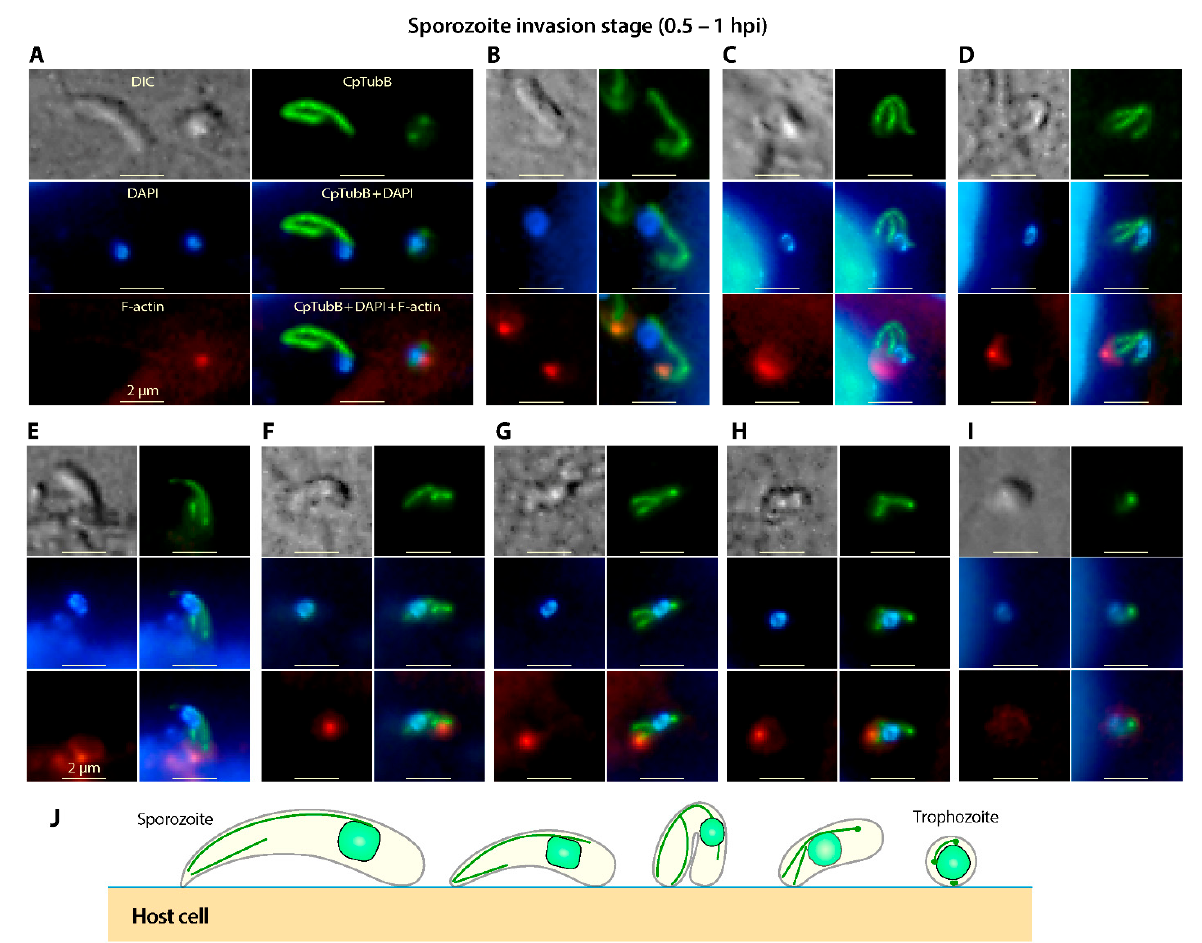
Figure 4. IFA detection of tubulin-based structures in Cryptosporidium parvum during the invasion of the host cell by sporozoites and its development into trophozoites by anti-CpTubB antibody (green). Nuclei were counterstained with 4 ′ ,6-diamidino-2-phenylindole (DAPI) (blue). Panels ( A – I ) represent various stages of transformation of banana-shaped sporozoites into small round trophozoites. Aggregated host cell F-actin at the infection site was stained with phalloidin-rhodamine (red). Panel ( J ) illustrates the morphological changes of the two microtubules in a sporozoite during invasion. For simplicty, the formation of parasitophorous vacuole membrane during the sporozoite invasion was not illustrated here. DIC, differential interference contrast microscopy.